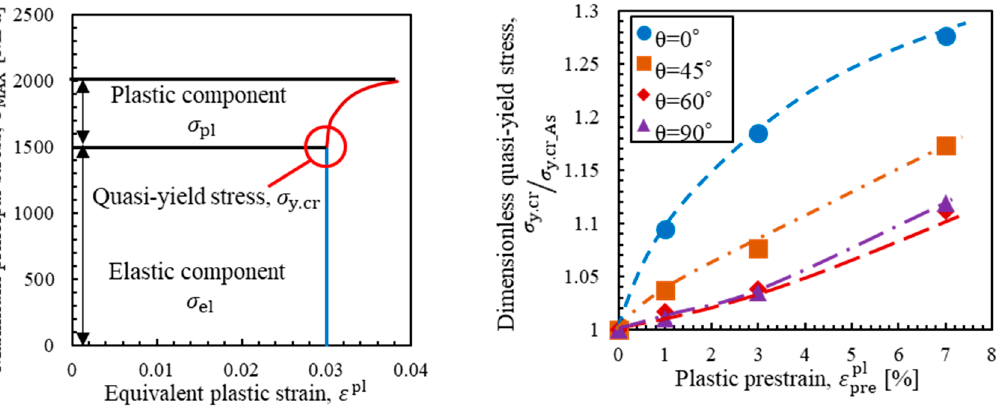
Figure 6. Change in quasi-yield stress due to prestrain in di ff erent directions. ( a ) Definition of σ y,cr , ( b ) Change in the dimensionless quasi-yield stress.